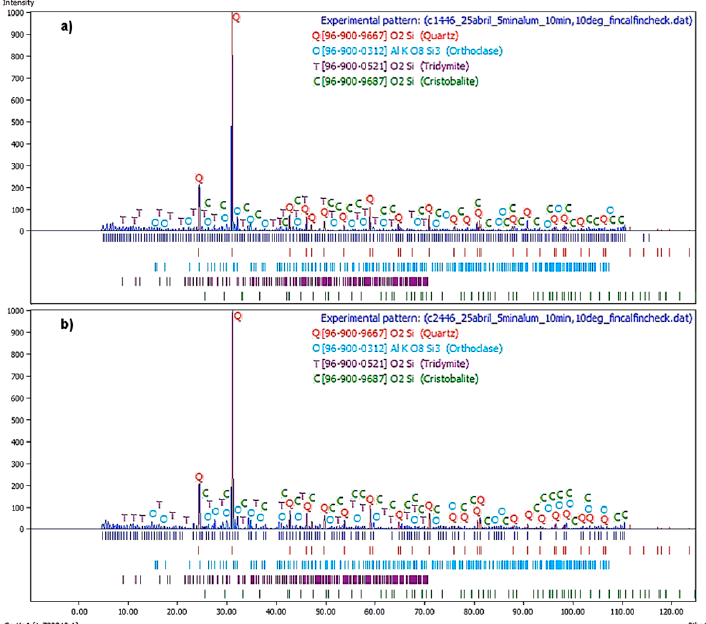
Figure 7. X-ray diffractogram of the material of the “Dos Carlos” dam recovered from the ( a ) first flotation stage at J lT = 0.47 & cm/s, and ( b ) second stage of flotation at J lT = 0.45 cm/s.